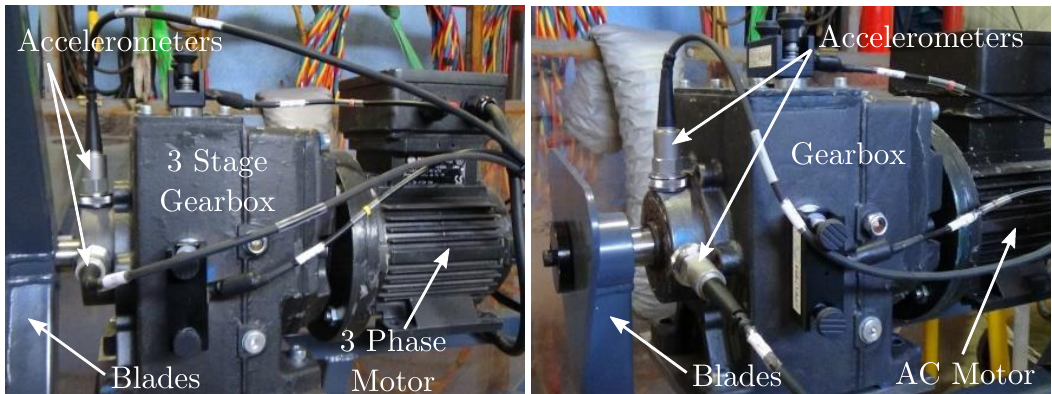
Figure 3. The test setup used to measure the vibration of the simple gearbox. On the left the system with 3 blades is visible and on the right a different setup with a single blade is